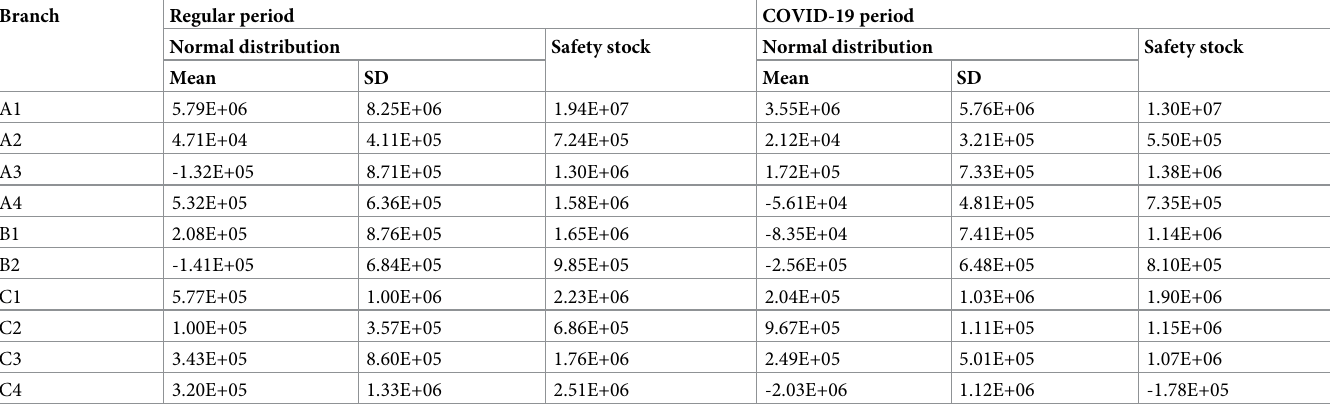
Table 12. Parameters of the normal distribution of the COCI prediction errors and the inverse of their cumulative distribution at α = 0.05.